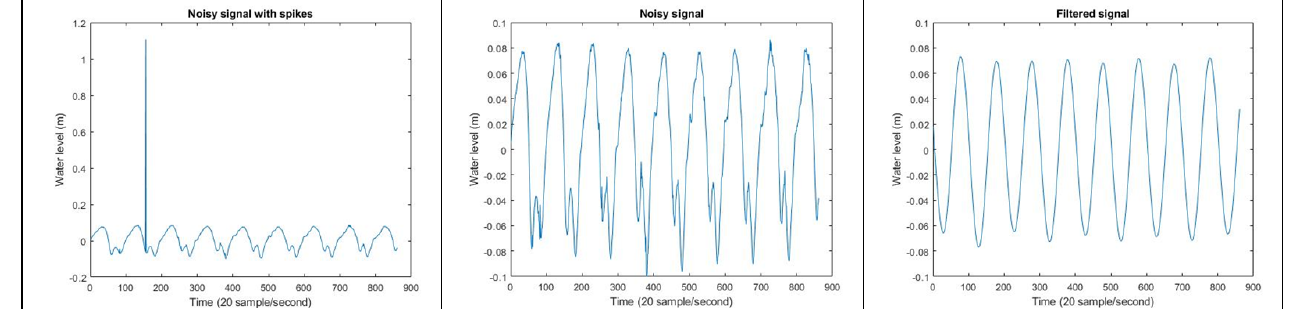
Figure A1 . Original signal, signal after removal of outliers using interpolation based on adjacent values, and signal after filtering based on cutoff frequency ranges.